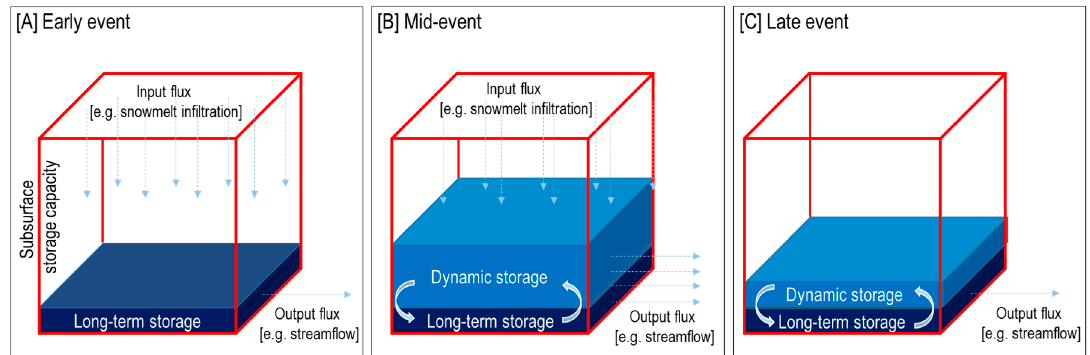
Figure 1. Conceptual model from the frame of reference of the subsurface storage capacity over the course of the hydrological event in three stages. ( A ) Early event shows a maximum snowpack beginning to infiltrate into the subsurface to add to the existing pre-event (long-term storage) water; ( B ) Mid-event shows snowpack continuing to infiltrate to contribute to the mix of dynamic and long-term storage waters; ( C ) Late event shows the depletion of the aggregation of mixed dynamic and stored waters after the end of snowmelt.